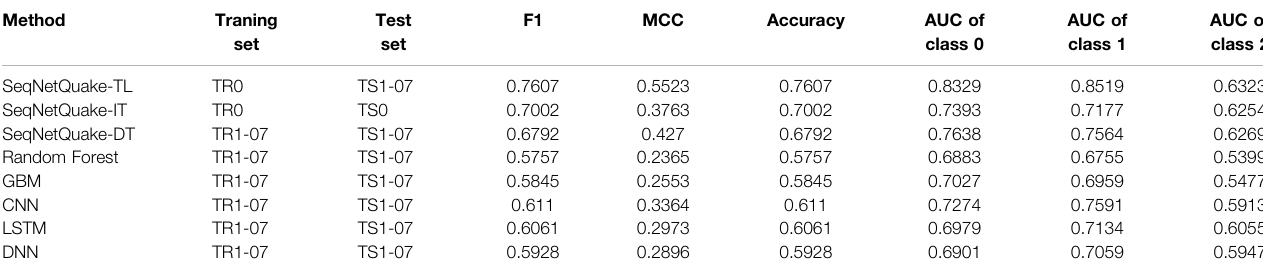
TABLE 2 | Performance of all classi fi ers on the test set TS1. Data from DEMETER were divided into a training set (TR0) and test set (TS0), and data from CSES were divided intoTR1(training set)and TS1(testset).SeqNetQuake-TL,SeqNetQuake-IT,andSeqNetQuake-DTindicatetheSeqNetQuakemodeltrainedviatransferlearning,initial training, and direct